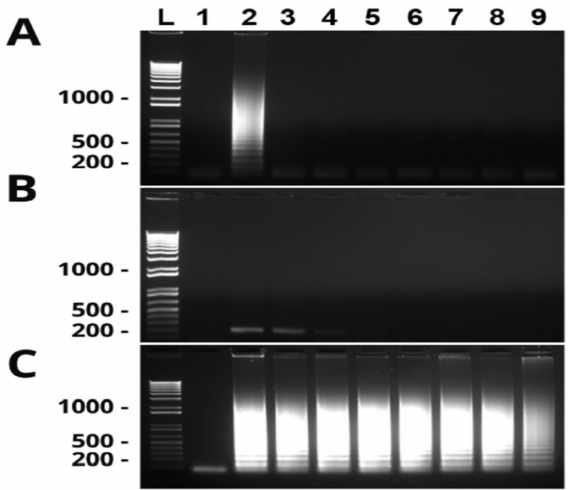
Figure 5. Limit of detection in spiked saliva samples as shown in gel electrophoresis. ( A ) LAMP. ( B ) PCR. Lane 1: nuclease-free water as a negative control; lane 2: positive controls with 100 ng T . tenax genomic DNA; lanes 3–9: canine saliva spiked with 2 × 10 5 , 2 × 10 4 , 2 × 10 3 , 2 × 10 2 , 2 × 10 1 , 2 × 10 0 and 2 × 10 − 1 cells, respectively. They were boiled at 100 ◦ C for 30 min with no DNA extraction. ( C ) LAMP using the similarly prepared samples as above that were re-suspended in TE buffer after being washed in PBS. L: 100 bp DNA ladder marker. One of three repeats is presented.